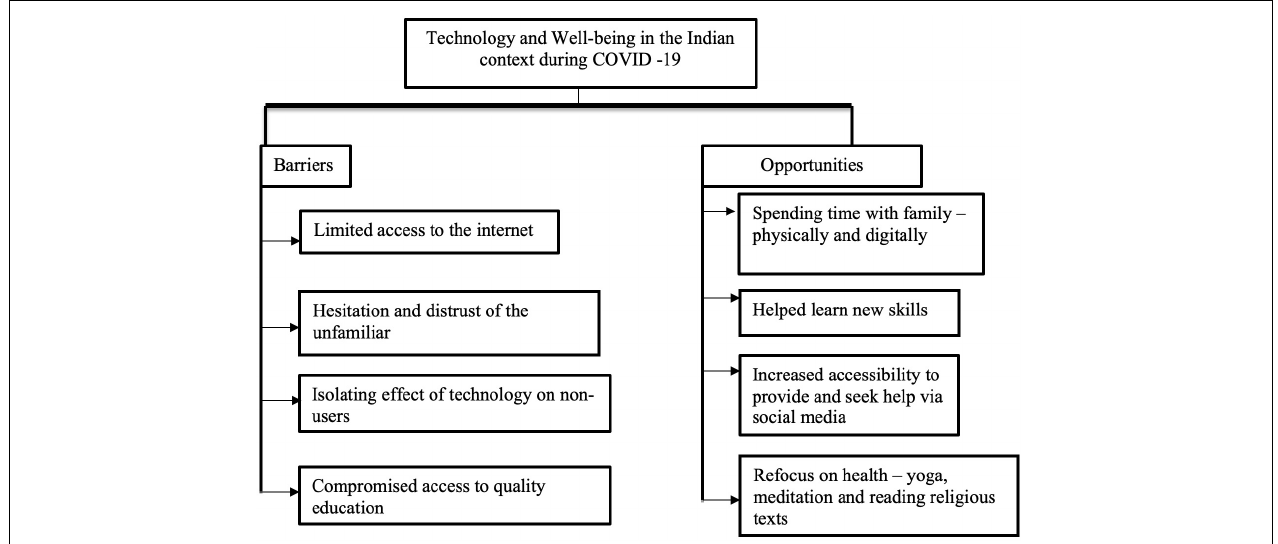
FIGURE 2 | Themes emerging from